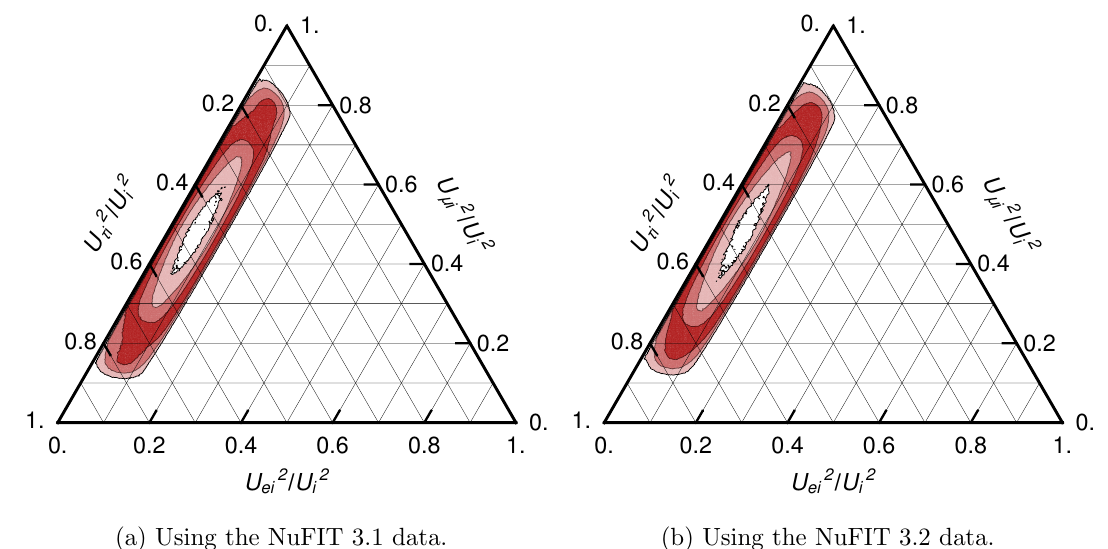
Figure 5. Illustration of the expected improvement in (cid:12)gure 3 with DUNE [91]. Here we assume Gaussian errors around the parameter (cid:14) = (cid:0) (cid:25)= 2 (cid:6) (cid:25)= 9 used as benchmarks in [92]. For all other parameters we take the one dimensional (cid:31) 2 projections from NuFIT 3.1 (a) and NuFIT 3.2